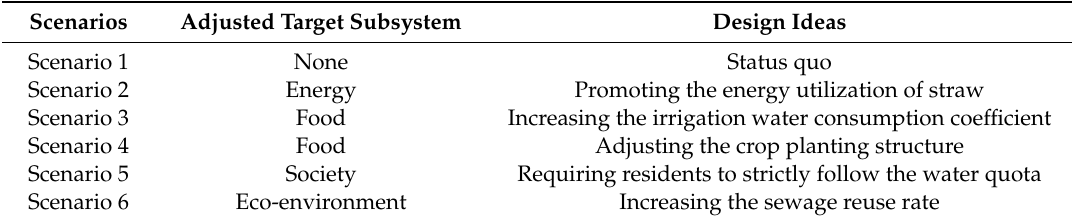
Table 3. Design ideas of the